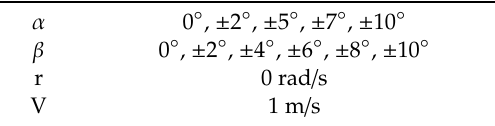
Table 3. Solving cases of position derivatives.